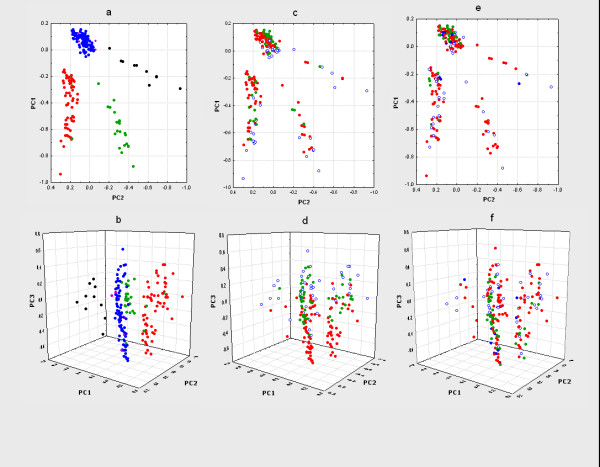
Clustering of tumour cases based on chromosomal imbalances using principal component analysis. In a, c, and e, two-dimensional representations based on the 1st and 2nd principal components are shown and in b, d, and f, three-dimensional representations are shown. In essence, the three-dimensional representations show a side-view and the two-dimensional representations a top-view of the clustering results. Colour codes in a and b: red, cases with 1p- without hsr/dmin; green, cases with 1p- and hsr/dmin; black, cases with dmin without 1p- ; purple, cases with hsr without 1p-; blue, other cases. Colour codes in c and d: red, tumours containing a higher number of whole-chromosome losses than whole-chromosome gains; green, tumours containing a higher number of gains than losses; empty circles, tumours not containing any whole-chromosome abnormalities. Colour codes in e and f: red, high risk tumours; green, low risk tumours; blue, intermediate risk tumours; empty circles, tumours with insufficient data for classification.